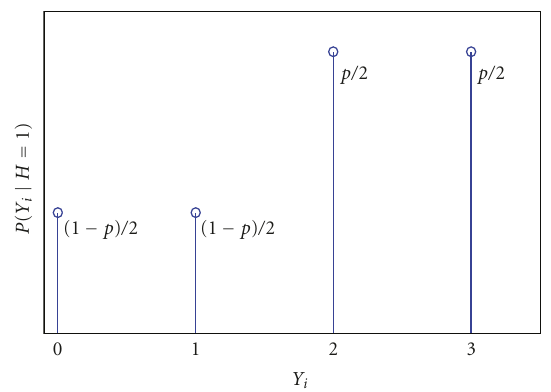
Figure 3: Probability mass function P ( Y i | H = 1) of 2-bit observation Y i made by sensor node S i . Here p is the precision of sensor and in general p > 0 . 5. For the above plot, an example value of precision p = 0 . 7 has been considered without the loss of generality.